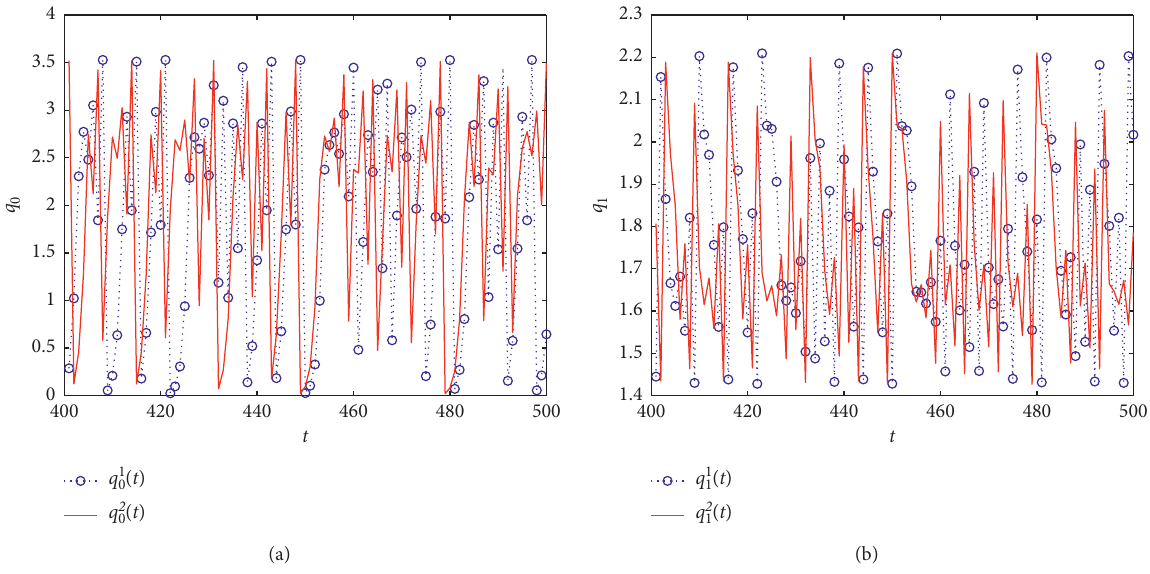
Figure 4: Sensitive dependence on initial conditions for system (11) in the time period [400, 500] when k � 2.